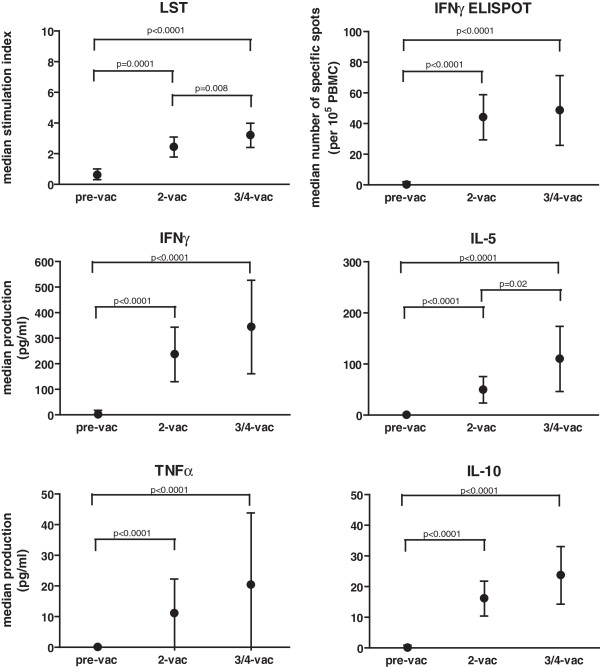
Vaccination results in stronger HPV16-specific immune responses. The strength (median + interquartile range) of the indicated immune response to all 6 pools of HPV16 E6 and E7 peptides for the whole group measured before vaccination (pre-vac), after 2 vaccinations (2-vac) and after the 3rd or 4th vaccination (3/4-vac) is given. Only when the strength of the immune response was significantly different, this is indicated by the p-value. Measured was the vaccine-induced proliferation as indicated by the stimulation index using the lymphocyte stimulation test, the antigen-specific increase in the numbers of IFNγ-producing T cells by ELISPOT, and the antigen-specific production of cytokines (IFNγ, IL-5, TNFα and IL-10) in the supernatant of the lymphocyte stimulation test detected by cytokine bead array.